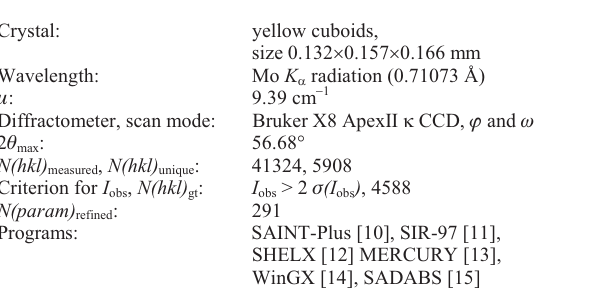
Table 1. Data collection and handling.